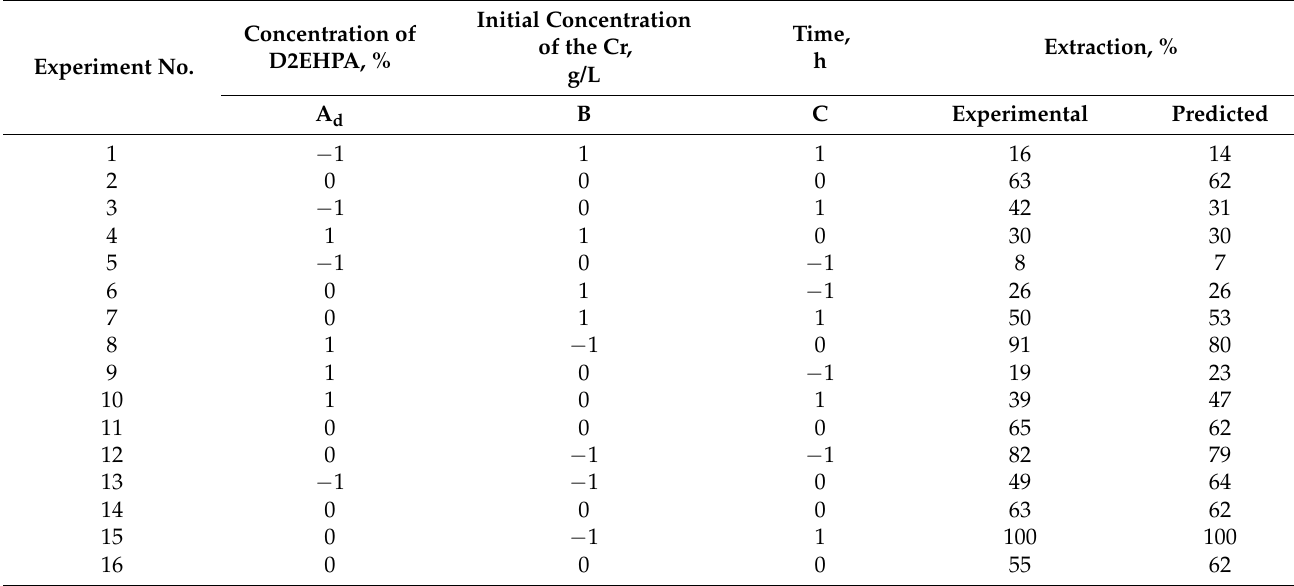
Table 8. BBD of process variables for experiment and values of experimental data for extraction of Cr(III) ions using DCSLM with threshold concentration of Cyanex272 and different proportions of D2EHPA.